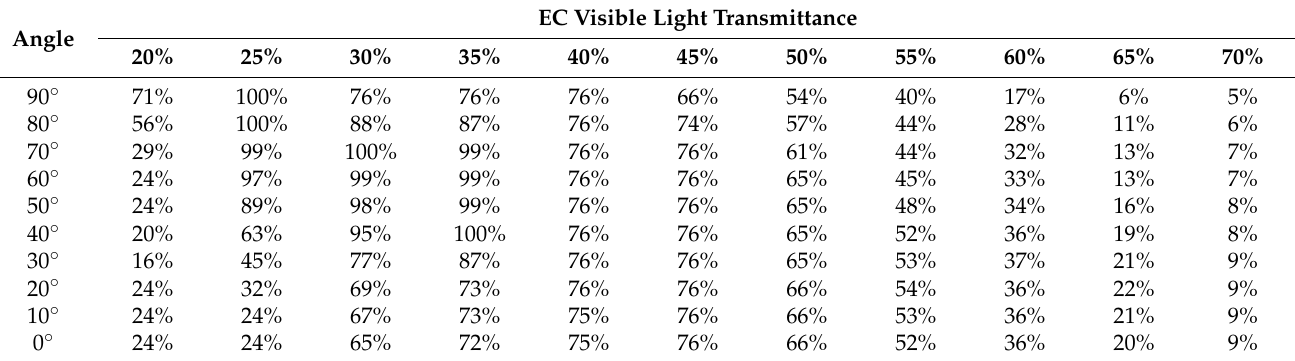
Table 4. Target illuminance achievement rates when the number of divisions of louvers is 10.